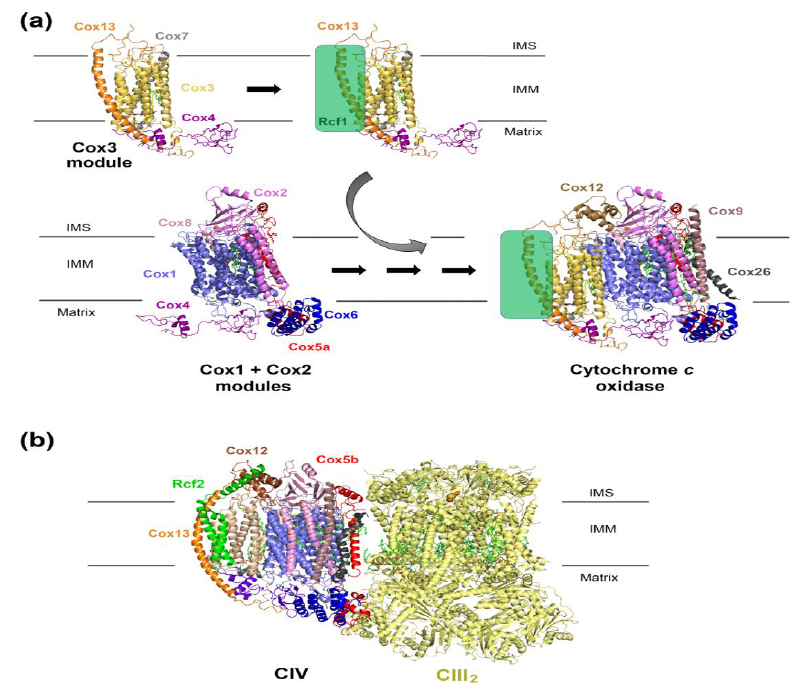
Figure 2. Proposed role of Rcf1 in the regulation of S. cerevisiae cytochrome c oxidase assembly